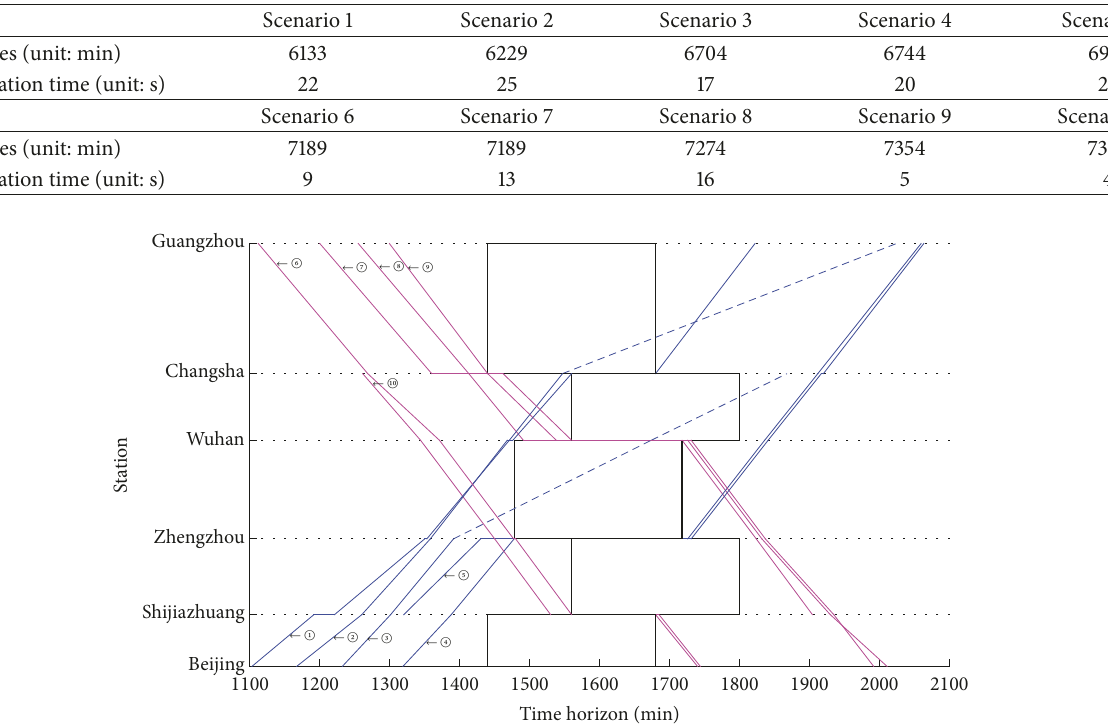
Figure 10: Time-space diagram of SDSA-trains at major stations.